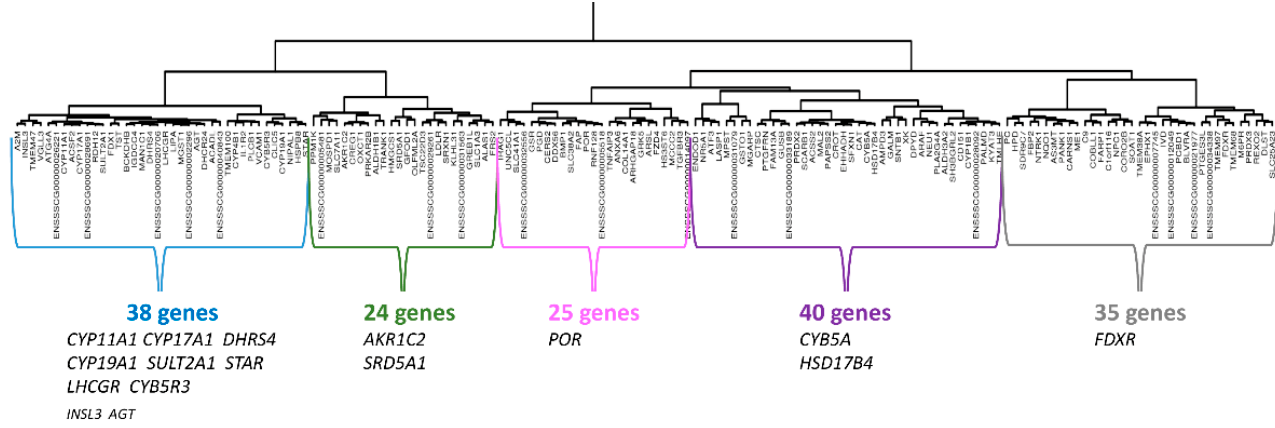
Figure 3. Presentation of CYP11A1-cluster-P162. An HCA was built with data (mRNAseq-P) observed for the 469 genes included in WGCNA-CYP11A1. The analysis of this clustering allowed the characterization of a group of 162 genes linked closely to CYP11A1 ( C YP11A1-cluster-P162). For the composition of sub-clusters, we have prioritized genes present in the group around CYP11A1 characterized by RT-qPCR (see Figure 1).